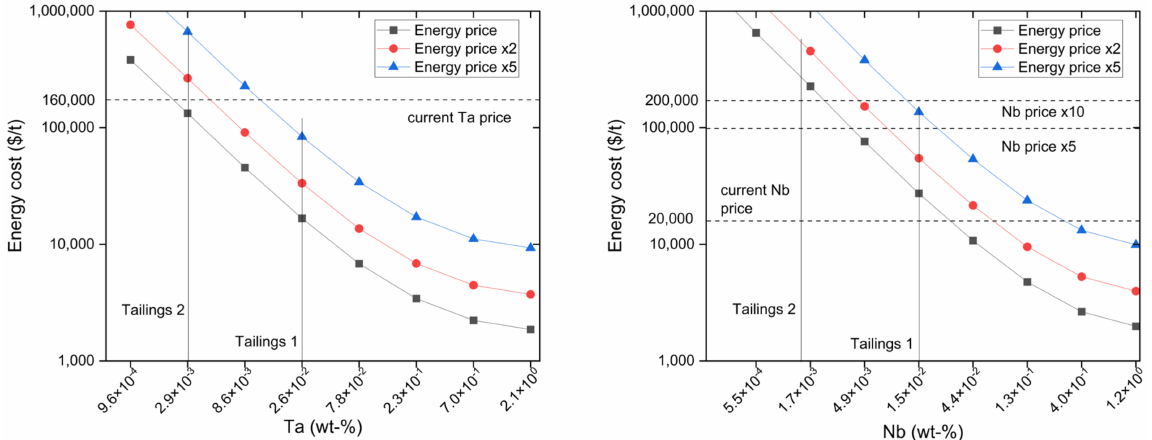
Figure 4. Evolution of energy costs as a function of ore-grade decline for different